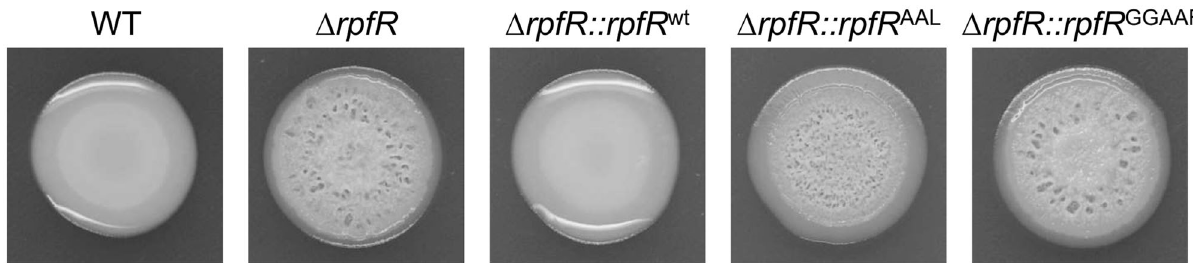
Fig. 6 Colony morphology of B. cenocepacia H111 strains to express RpfR variants. Alleles for wild-type rpfR , rpfR AAL , and rpfR GGAAF were crossed back into the rpfR mutant by allelic exchange, generating strains Δ rpfR::rpfR wt , Δ rpfR::rpfR AAL , and Δ rpfR::rpfR GGAAF , respectively. The wild-type strain, the parental strain Δ rpfR, and strains encoding RpfR variants were assayed for colony morphology on NYG agar